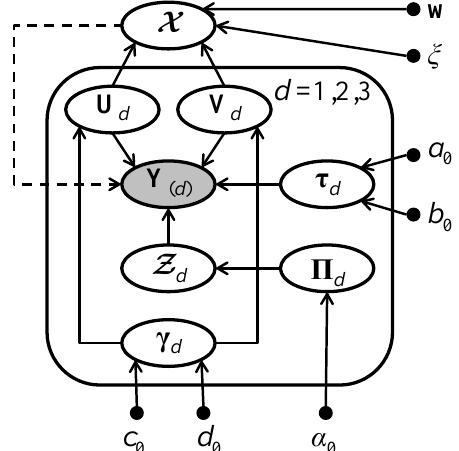
Figure 1. Graphical model of NMoG-Tucker. Hollow nodes, shadowed nodes, and small solid nodes denote unobserved variables, observed data, and hyperparameters, respectively; a solid arrow from node a to node b indicates the explicit conditional distribution p ( b | a ) ; a dashed arrow from node a to node b implies that b is implicitly conditioned on a ; the box is a compact representation indicating that there are three sets of variables corresponding to the three tensor